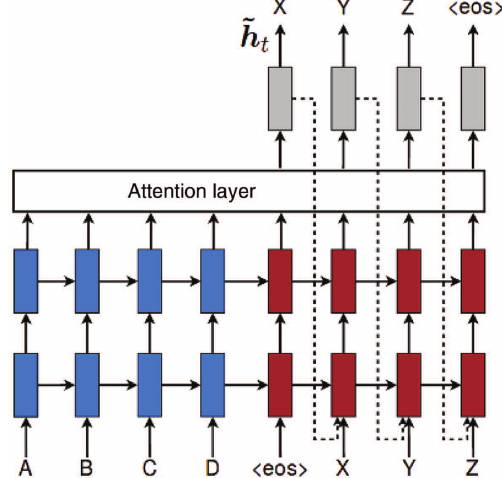
Figure 2: System Architecture for